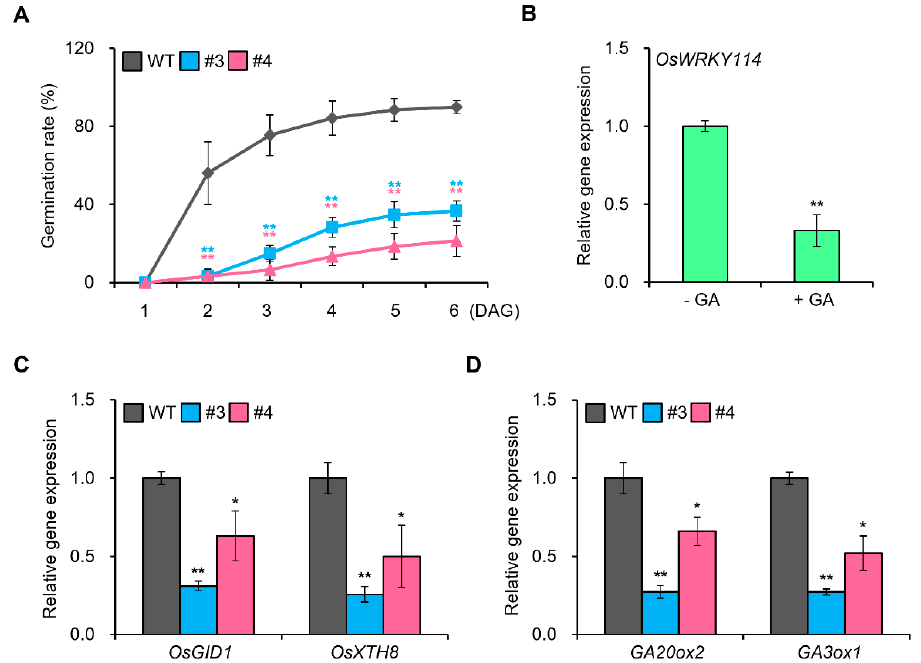
Figure 1. OsWRKY114 is involved in GA responses. ( A ) Germination rate of OsWRKY114 OX . Germination rate was measured in 36 kernels each from two OsWRKY114 OX plants (#3 and #4) and one wild-type (WT) plant grown on half-strength MS medium in a growth room under continuous light at 28 ◦ C for 6 days. Values are expressed as means ± SD. Asterisks indicate values significantly different from those of the WT (** p < 0.01). DAG, days after germination. ( B ) Relative expression levels of OsWRKY114 in WT plants after GA treatment. WT plants were grown on MS medium with or without 1 µ M GA 3 for 6 DAG. The transcript levels of OsWRKY114 were analyzed by RT-qPCR. OsActin was used as an internal control to quantify relative gene expression. Values are expressed as means ± SD. Asterisks indicate values significantly different from those of the non-GA-treated control (** p < 0.01). ( C , D ) Relative expression levels of GA-related genes in OsWRKY114 OX . Total RNA was extracted from 6-day-old OsWRKY114 OX and WT seedings. Transcript levels of genes involved in GA signaling ( C ) and GA biosynthesis ( D ) were analyzed using RT-qPCR. OsActin was used as an internal control to quantify relative gene expression. Values are expressed as means ± SD. Asterisks indicate values signi fi cantly di ff erent from those of the WT control (* p < 0.05 and ** p < 0.01). All experiments were repeated at least three times with similar results. Representative graphs are shown.